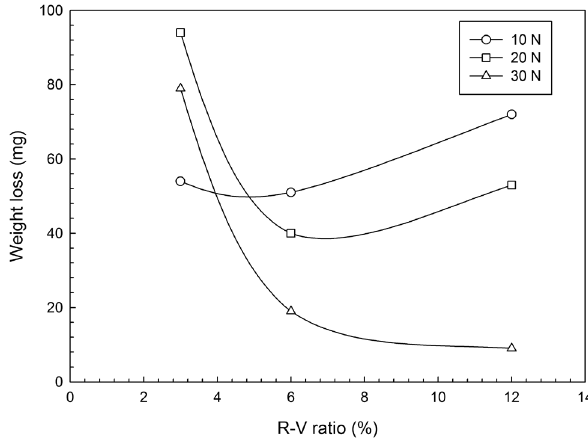
Fig. 11: Weight loss of the 3%, 6% and 12% R-V ratio composites, manufactured at 800 °C temperature and 500 rev/min stirring speed in 4 minutes, which were tested with 320 mesh (44 µm particle size) abrasive under 10N, 20N and 30N load